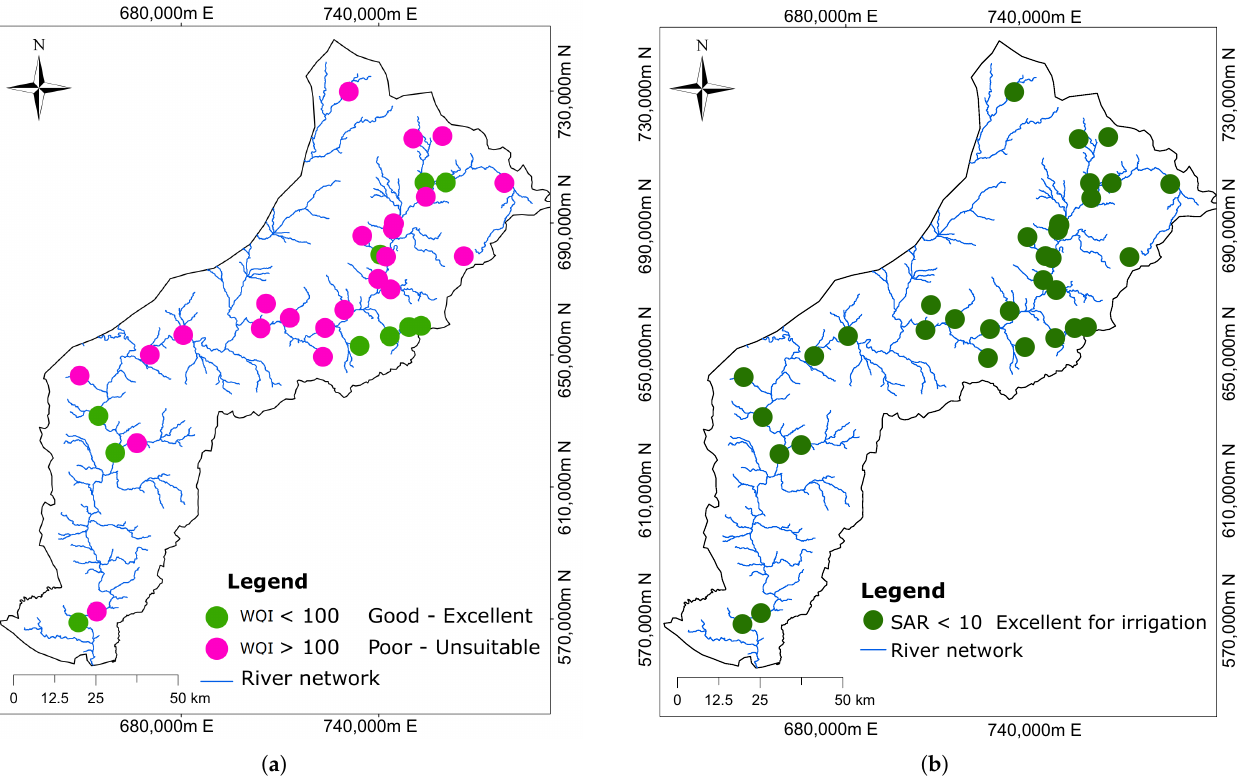
Figure 4. Surface water spatial distribution maps of ( a ) Water Quality Index (WQI) and ( b ) Sodium Adsorption Ratio (SAR) for the assessment of water quality for drinking and irrigation purposes